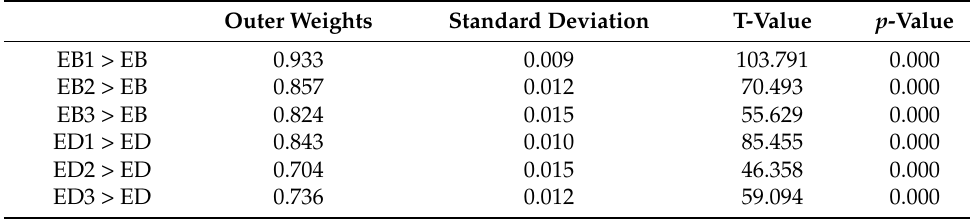
Table 5. Statistical analysis of formative measurement